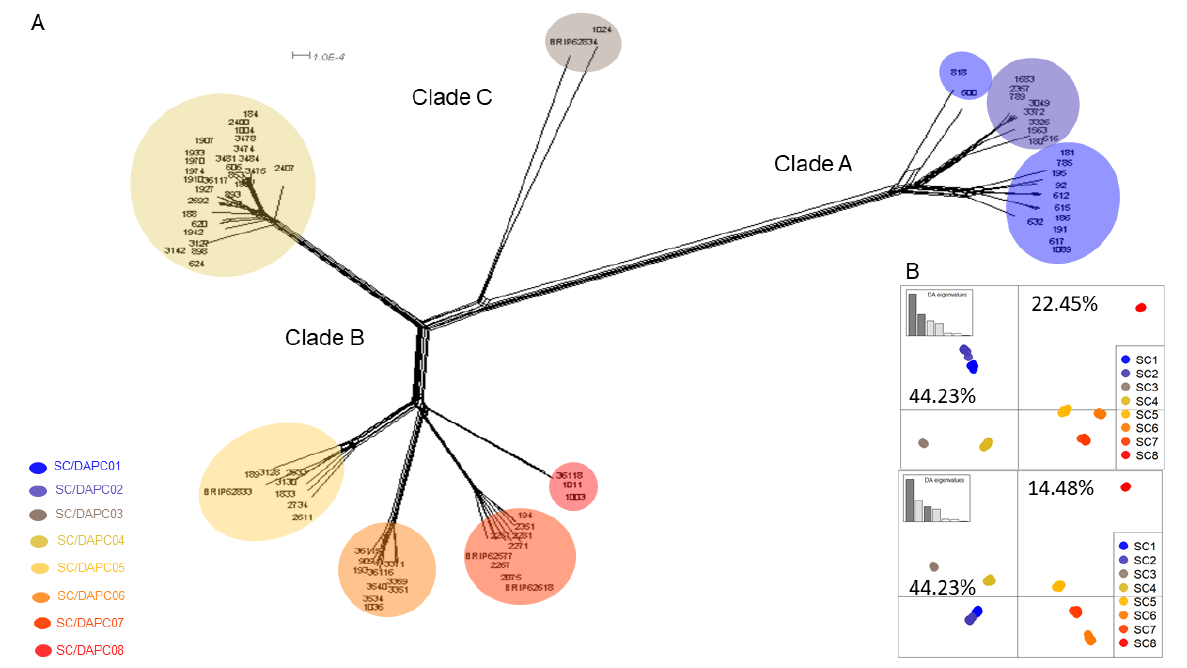
Figure 2. Clustering analysis indicating Fusarium oxysporum f. sp. cubense ( Foc) consists of eight distinct genetic clusters. ( A ): SplitsTree clustering network based on the distance between 83 Foc isolates as indicated by 5240 binary SNP markers. Different snapclust (SC) or discriminant analysis of principal component (DAPC) groups are shown by different colours, while individual isolates are indicated on each root tip. Foc clade identities as determined by O’Donnell et al. [40] are indicated on branches. ( B ): Scatterplots of the DAPC of the Foc data, based on the Discriminant functions (DA) 1 – 3. The two scatterplots reported the discrimination of the eight genetic on the plan DA1-DA2 ( top ) and DA1-DA3 ( bottom ). The percentages on each scatterplot indicate the inertia rate of each axis (which can be interpreted as the percentage of variation explained by the axis), while the SC groups are shown by different colours, and dots represent individual